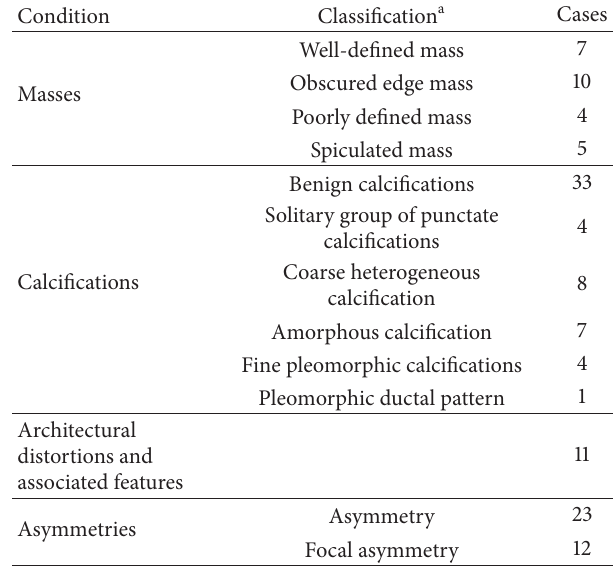
Table 2: Detailed classification of the cases in the